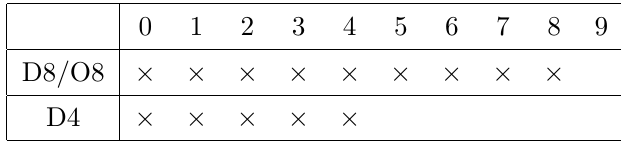
Table 1 . The D4-D8/O8-brane system in type I’ string